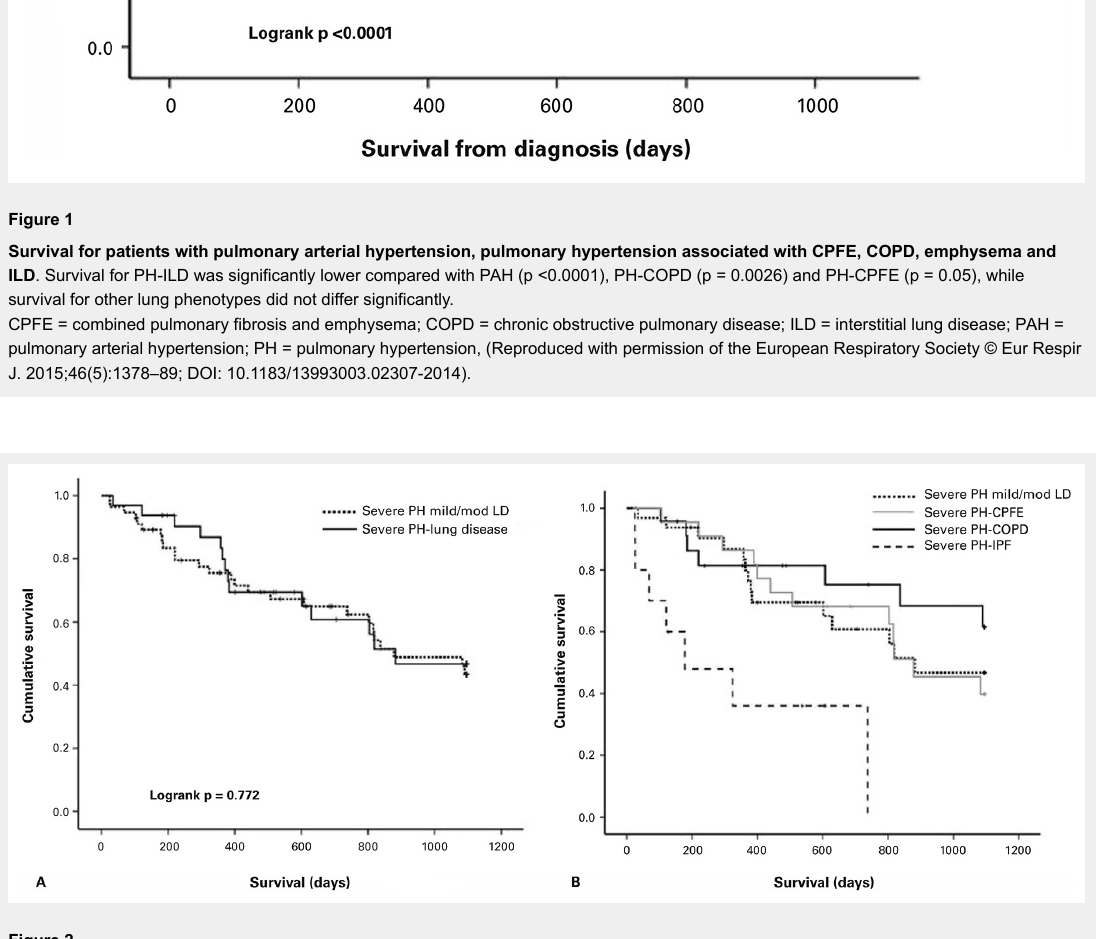
Figure 2 Survival by severity of lung disease. For patients fulfilling the definition of severe PH (mPAP >35 mm Hg or CI <2.0 l/min/m 2 ) and mild/ moderate lung disease (FEV1 >60%), there was no difference in survival observed compared to severe PH/ severe lung disease (Panel A). On the contrary, in patients with severe PH, the underlying lung disease had a significant impact on survival (Panel B). CPFE = combined pulmonary fibrosis and emphysema; COPD = chronic obstructive pulmonary disease; ILD = interstitial lung disease; LD = lung disease; PH = pulmonary hypertension. (Reproduced with permission of the European Respiratory Society © Eur Respir J. 2015;46(5):1378–89; DOI: